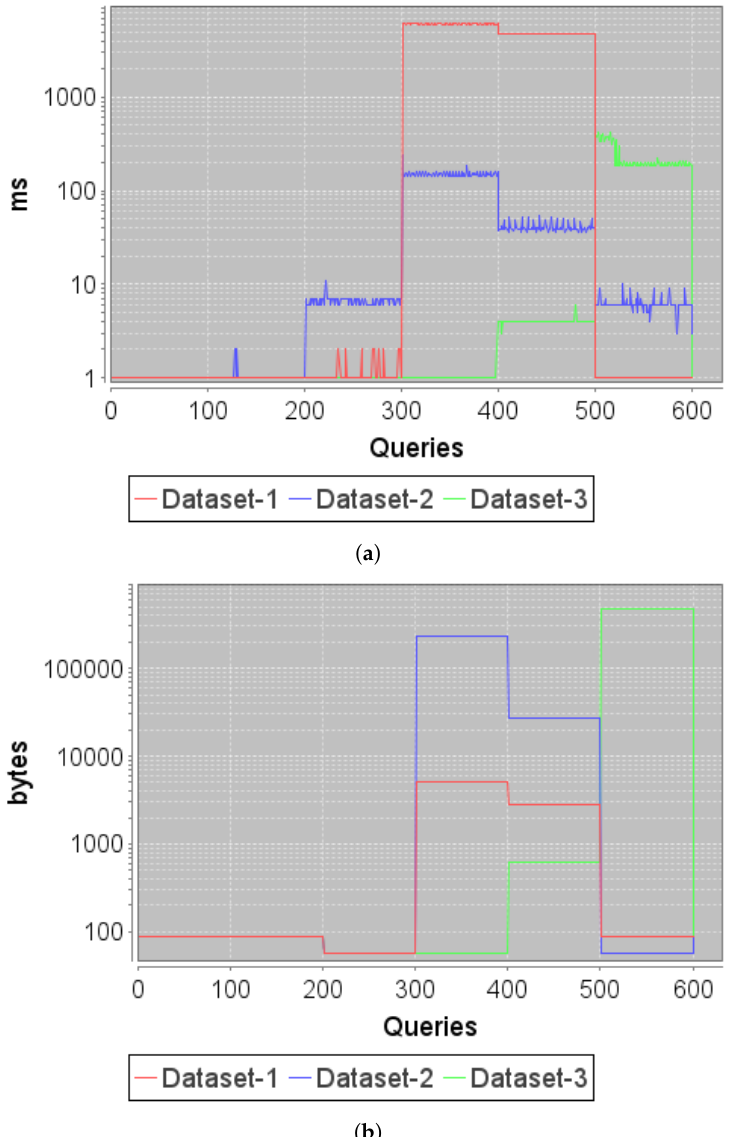
Figure 6. Cached query sets. ( a ) Cached query sets. Response time in ms (milliseconds). ( b ) Cached query sets. Response volume in